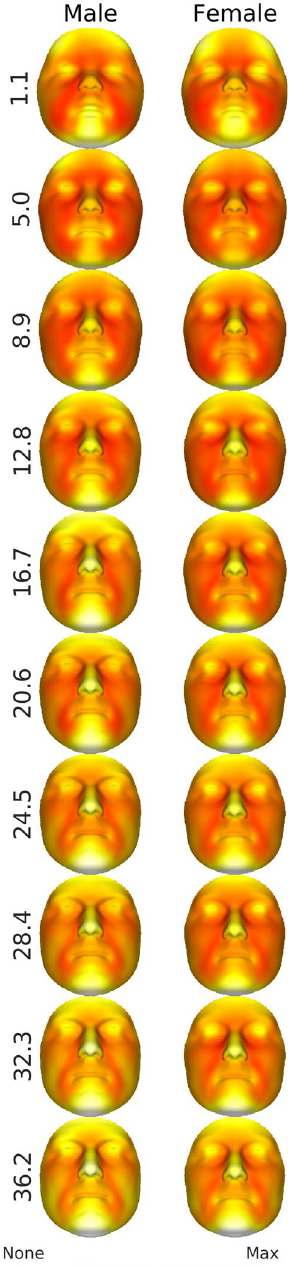
Figure 4. Root mean-square variation around the expected faces for some example ages. All color-maps use the same color-scale and are therefore comparable visually. This figure was generated in MATLAB 2021a (https:// www. mathw orks.